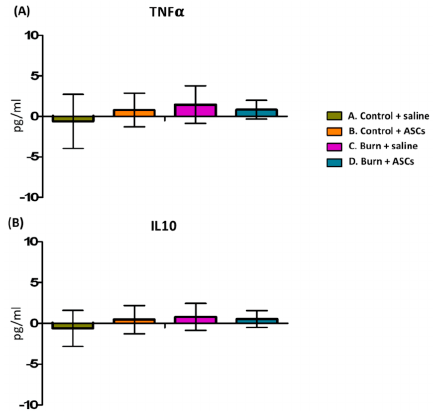
Figure 3. Insignificant difference of TNF- α and IL-10 levels at week 8 in serum among four groups.